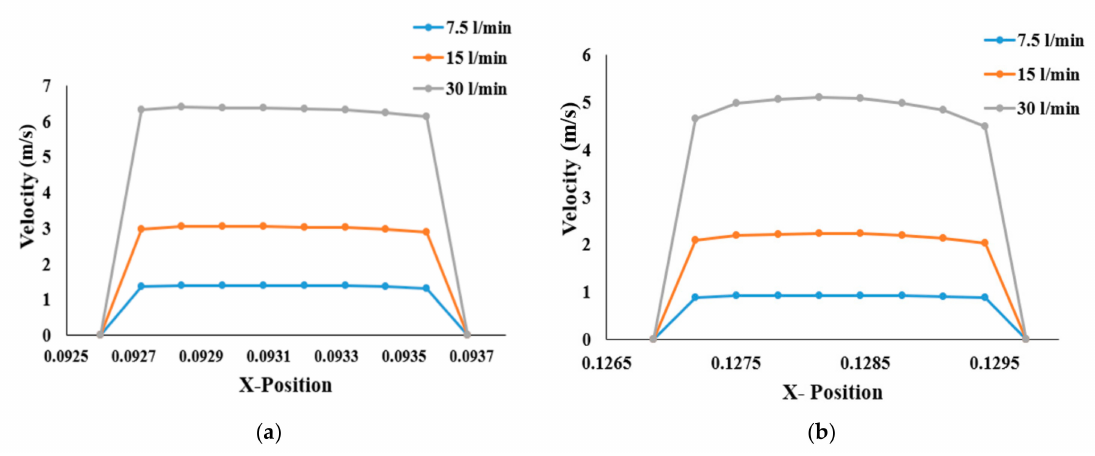
Figure 6. Velocity profiles at the stenosis section of the airway: ( a ) right stenosis and ( b ) left stenosis models.